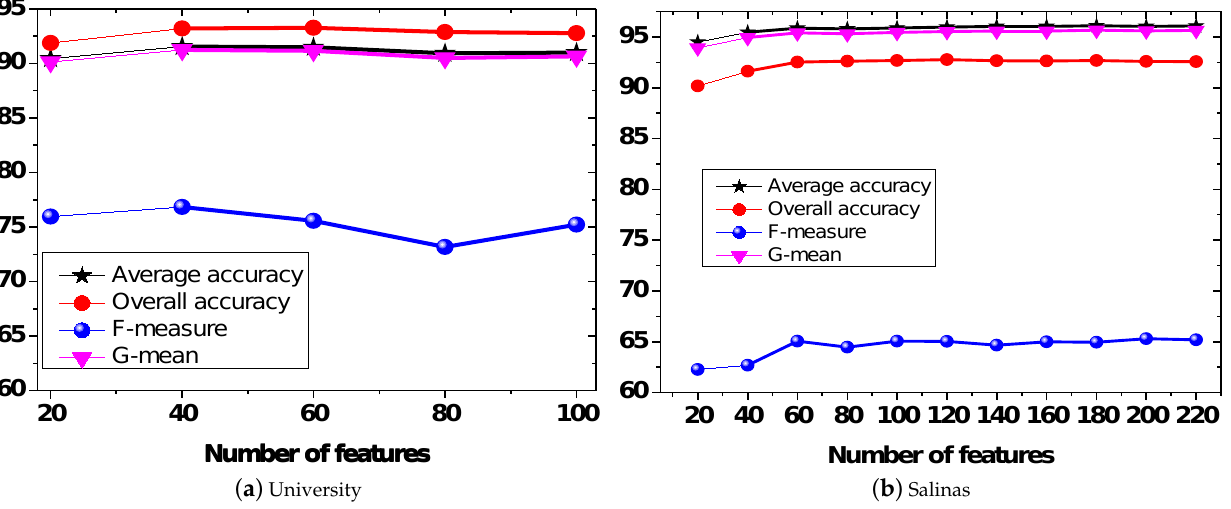
Figure 6. Performances of the proposed method measured by OA , AA , F — measure and G — mean with respect to the number of features on hyperspectral data sets University and